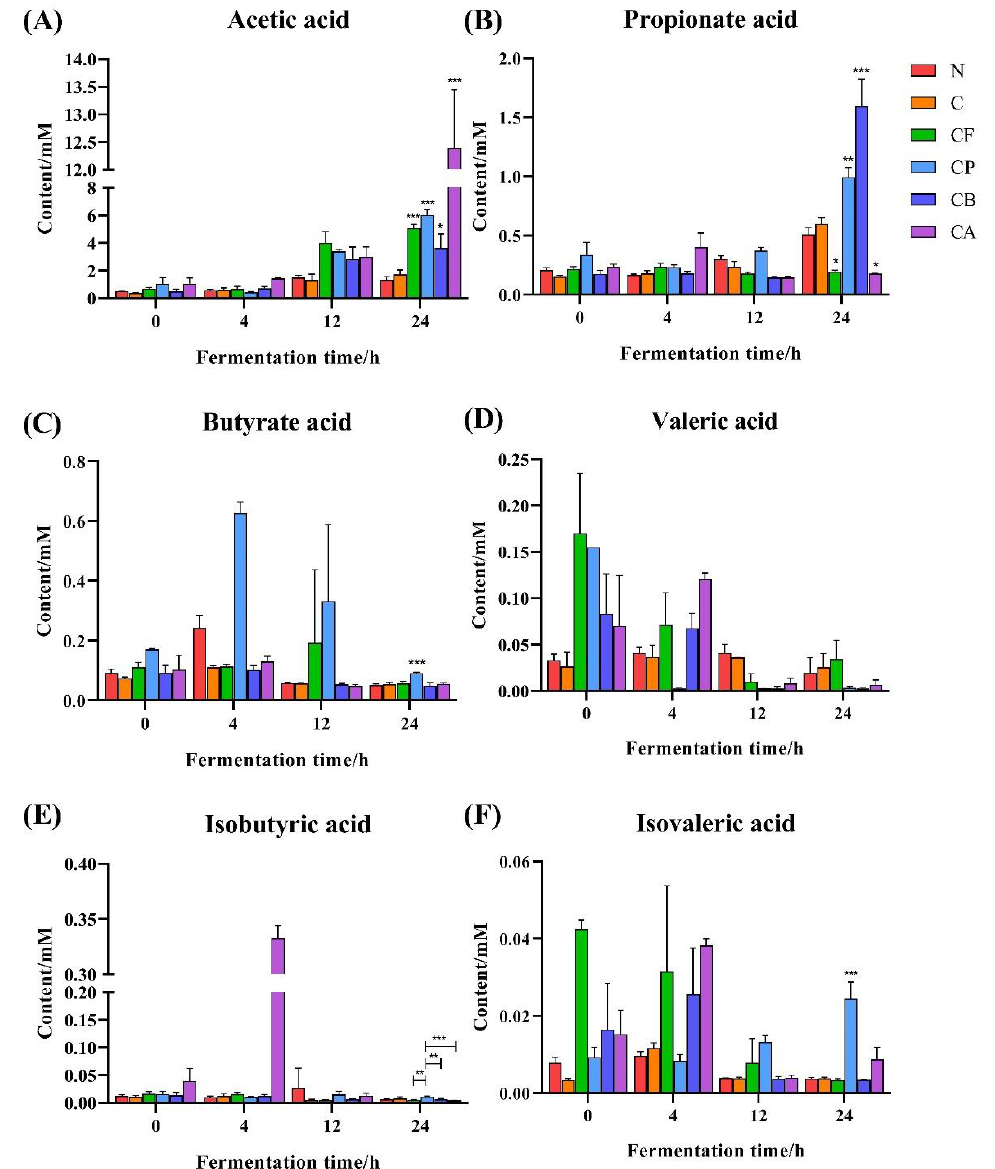
Figure 8. Effects of C3G mixed with different polysaccharides on SCFAs during in vitro fermentation: ( A ) acetic acid, ( B ) propionic acid, ( C ) butyric acid, ( D ) valeric acid, ( E ) isobutyric acid, and ( F ) isovaleric acid. Asterisks indicate significant difference between N group and other five groups at 24 h of fermentation, respectively, except for isobutyric acid: * ( p < 0.05), ** ( p < 0.01) and *** ( p < 0.001). Values are means ± SD for n = 3